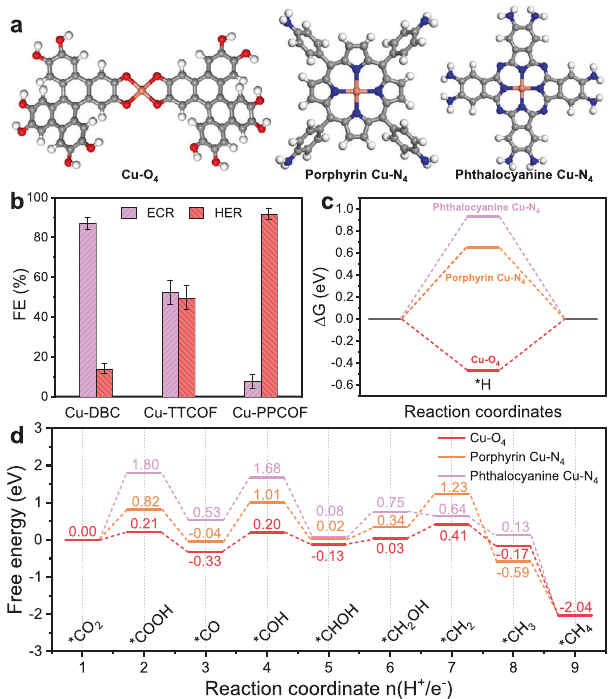
Fig. 4 The dependence of ECR selectivity on Cu-site coordination environment. a Schematic of DFT calculation models for Cu – O 4 , porphyrin Cu – N 4 , and phthalocyanine Cu – N 4 sites in the Cu-DBC, Cu-TTCOF, and Cu-PPCOF catalysts. Gray, blue, red, white, and orange spheres represent C, N, O, H, and Cu atoms, respectively. b FEs for ECR and HER recorded at − 0.9 V vs. RHE on different single Cu site electrocatalysts. c The energy pro fi les of *H adsorption on different catalytic sites by DFT